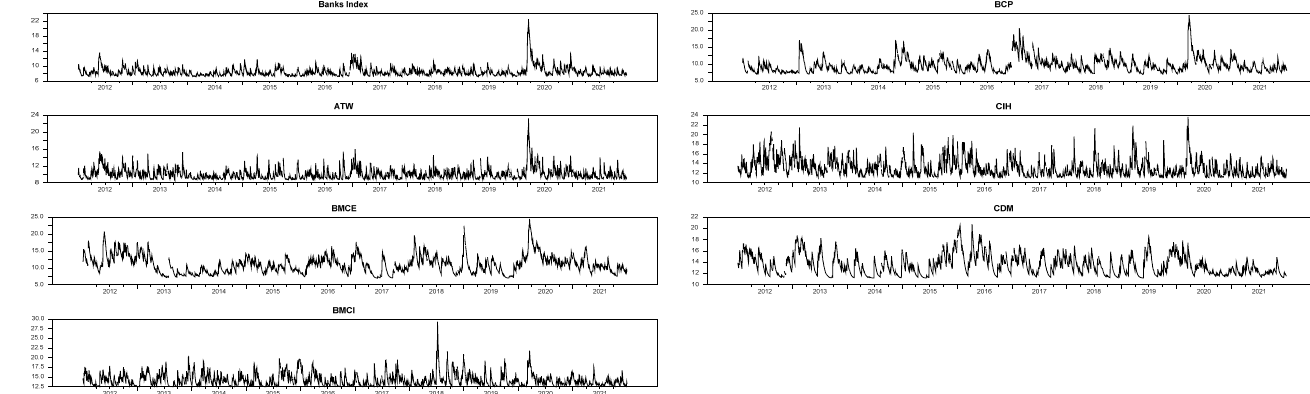
Figure 5. Daily Bank Volatility Index Percent.